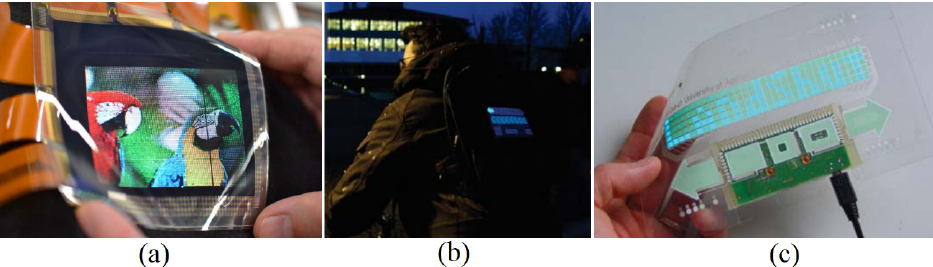
Figure 10. ( a ) A flexible color display (Reprinted with permission from [128]. Copyright 2018 IEEE); ( b ) a screen printed electroluminescent matrix display integrated into a back pack; ( c ) a closer look of the screen printed electroluminescent matrix display with the controlling module (Reprinted